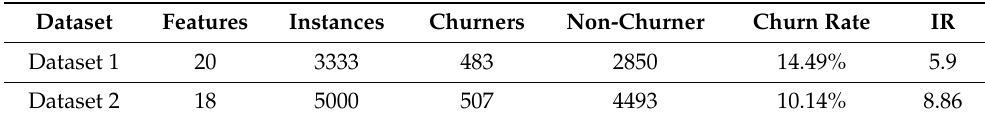
Table 2. Description of CCP